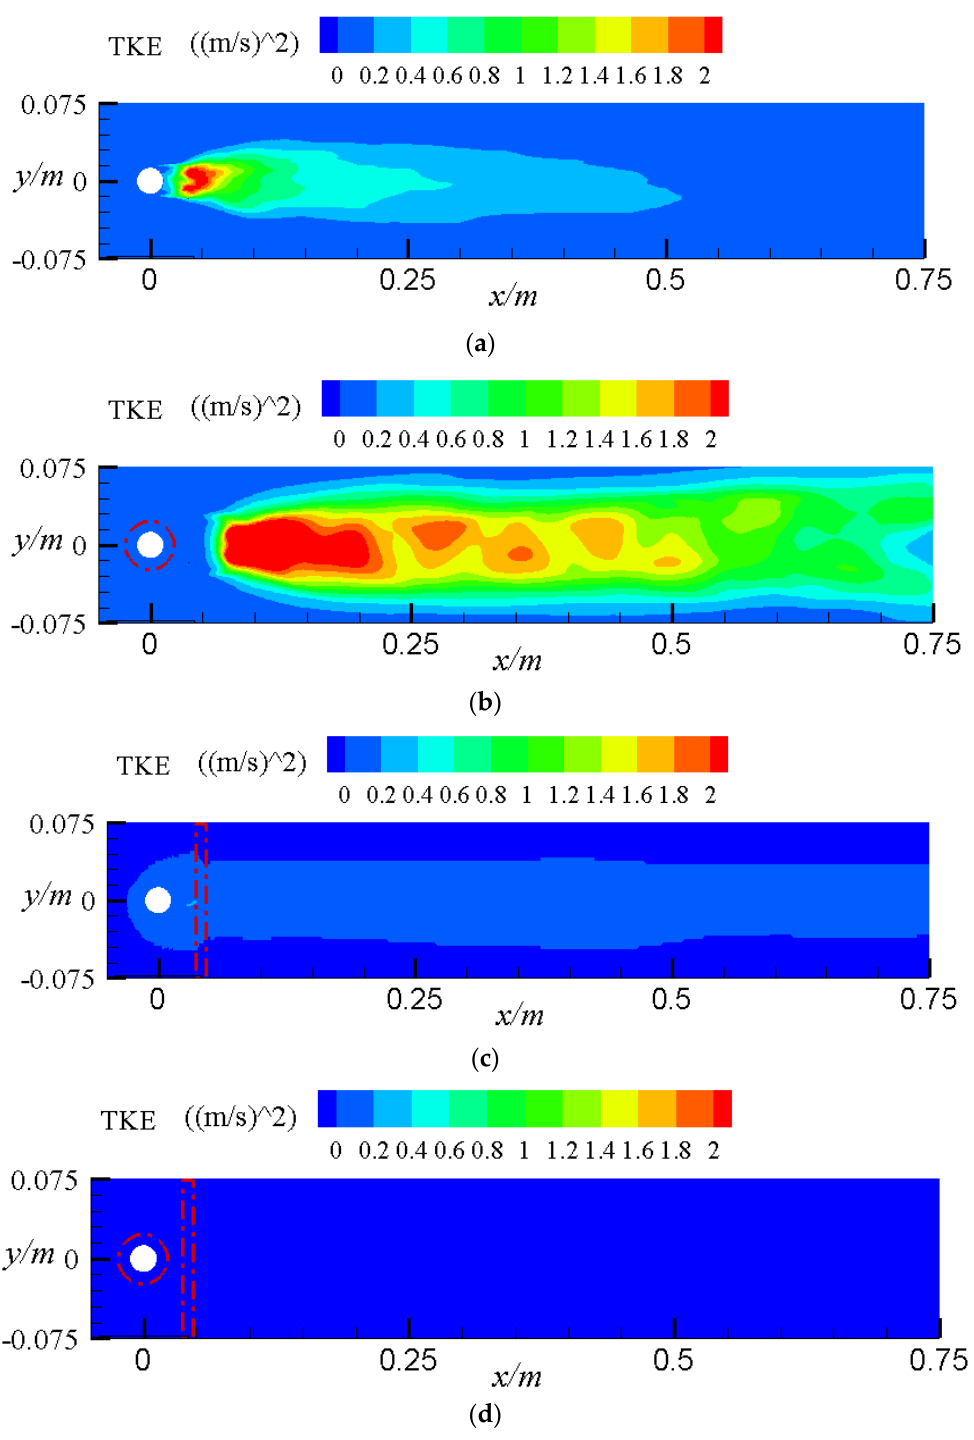
Figure 18. Turbulent kinetic energy at Z = 0 plane: ( a ) Cylinder; ( b ) PC; ( c ) CP; ( d ) PCP. Overall, the wake evolution is highly affected by the location of the porous materials.